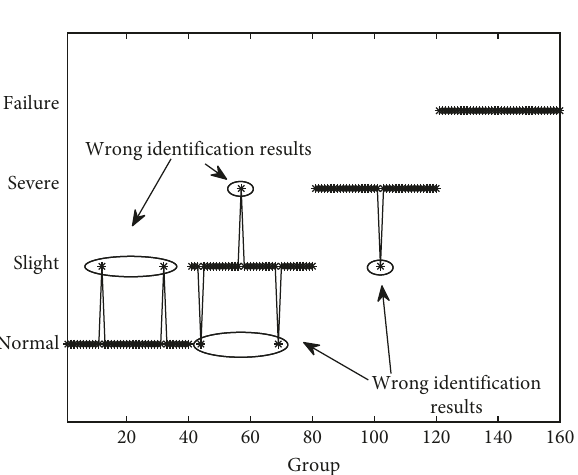
Figure 11: Recognition results of the whole 160 groups of test